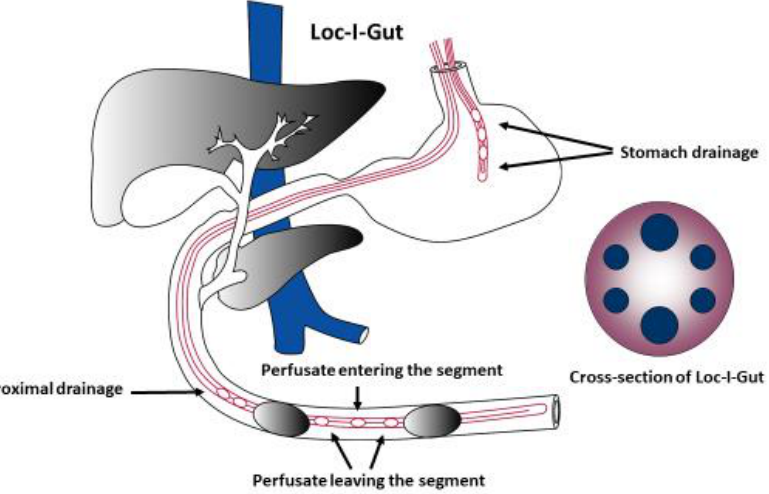
Figure 8. Schematics of the intestinal perfusion system used for in vivo studies in humans: Loc-I-Gut is a single-pass perfusion, double-balloon technique for the proximal small intestinal regions. The multichannel GI tube made from polyvinyl chloride (PVC) is 175 cm long, has an external diameter of 5.3 mm, contains six channels, and distally has two 40 mm long latex balloons (10 cm apart). These balloons are separately connected to one of the smaller channels, and the two wider channels are for infusion and aspiration of the perfusion solution. The two remaining smaller channels are for the infusion of marker substances and/or for drainage. A tungsten weight facilitates the passage of the tube into the jejunum. 14 C-PEG 4000 is used as a non-absorbable volume marker to monitor water flux across the intestinal mucosa throughout the in vivo perfusion experiment.